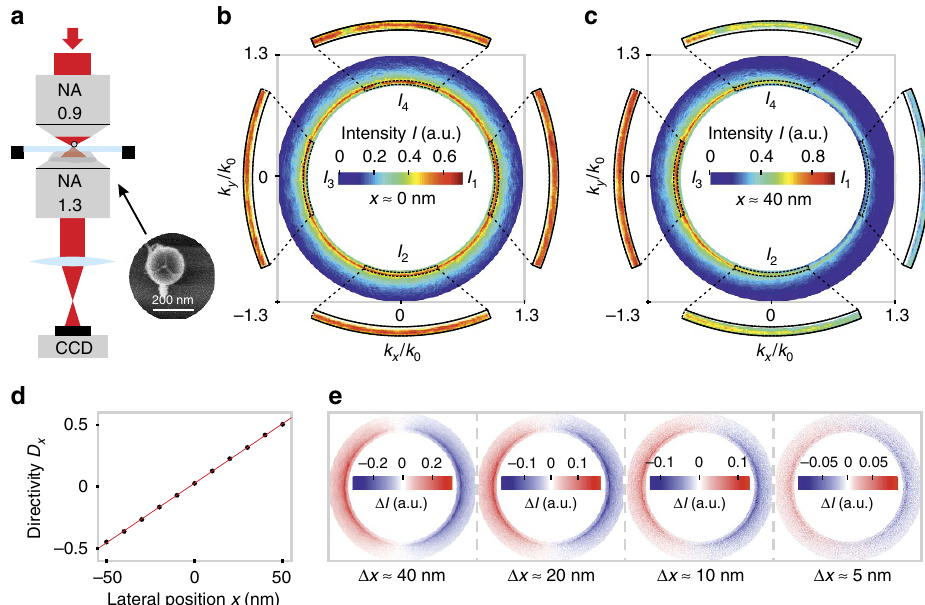
Figure 3 | Set-up and experimental results. ( a ) A radially polarized collimated beam is tightly focused by a microscope objective (NA ¼ 0.9) onto a sub-wavelength silicon antenna sitting on a glass substrate (see inset). The light emitted into the angular regime with NA A [0.95, 1.3] is collected by an oil-immersion type microscope objective (NA ¼ 1.3). The back-focal plane is imaged onto a CCD camera. ( b ) Acquired far-field intensity distribution I ( k x , k y ) for the antenna placed on the optical axis and ( c ) for the antenna displaced laterally by x E 40nm (off-axis). The dashed black lines and the magnified insets indicate four regions with averaged intensities I 1 , I 2 , I 3 and I 4 . ( d ) Directivity parameter D x versus the antenna’s position along the x axis; the slope of the curve (0.01nm (cid:2) 1 ) defines the sensitivity of the measurement to the antenna displacement. ( e ) Far-field intensity difference images for four antenna positions along the x axis (left to right: D x E 40, 20, 10 and 5nm away from the optical axis). The left image corresponds to the intensity difference D I ( k x , k y ) between b , c